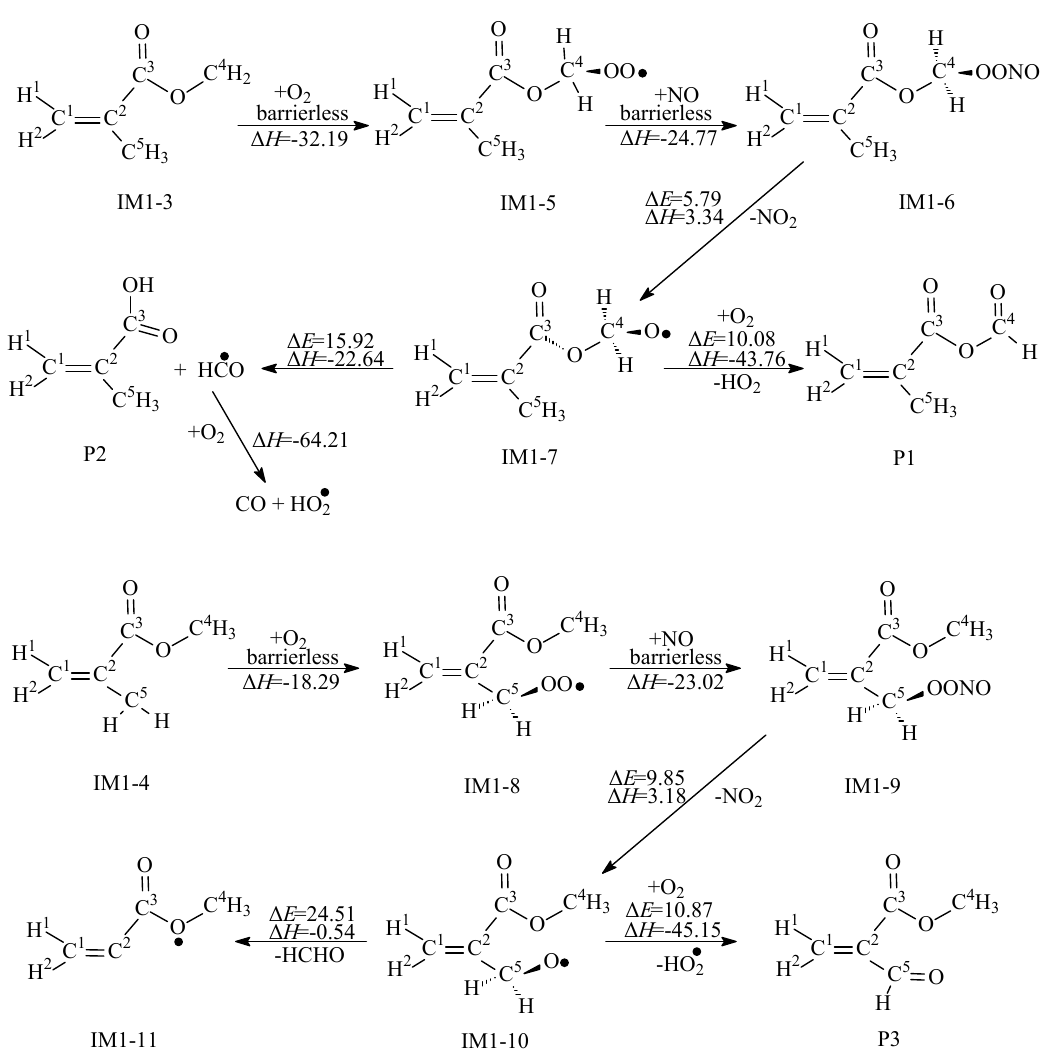
Figure 3. Secondary reaction of IM1-3 and IM1-4. Unit: kcal/mol. Δ E : the potential barriers; Δ H : reaction heats (0